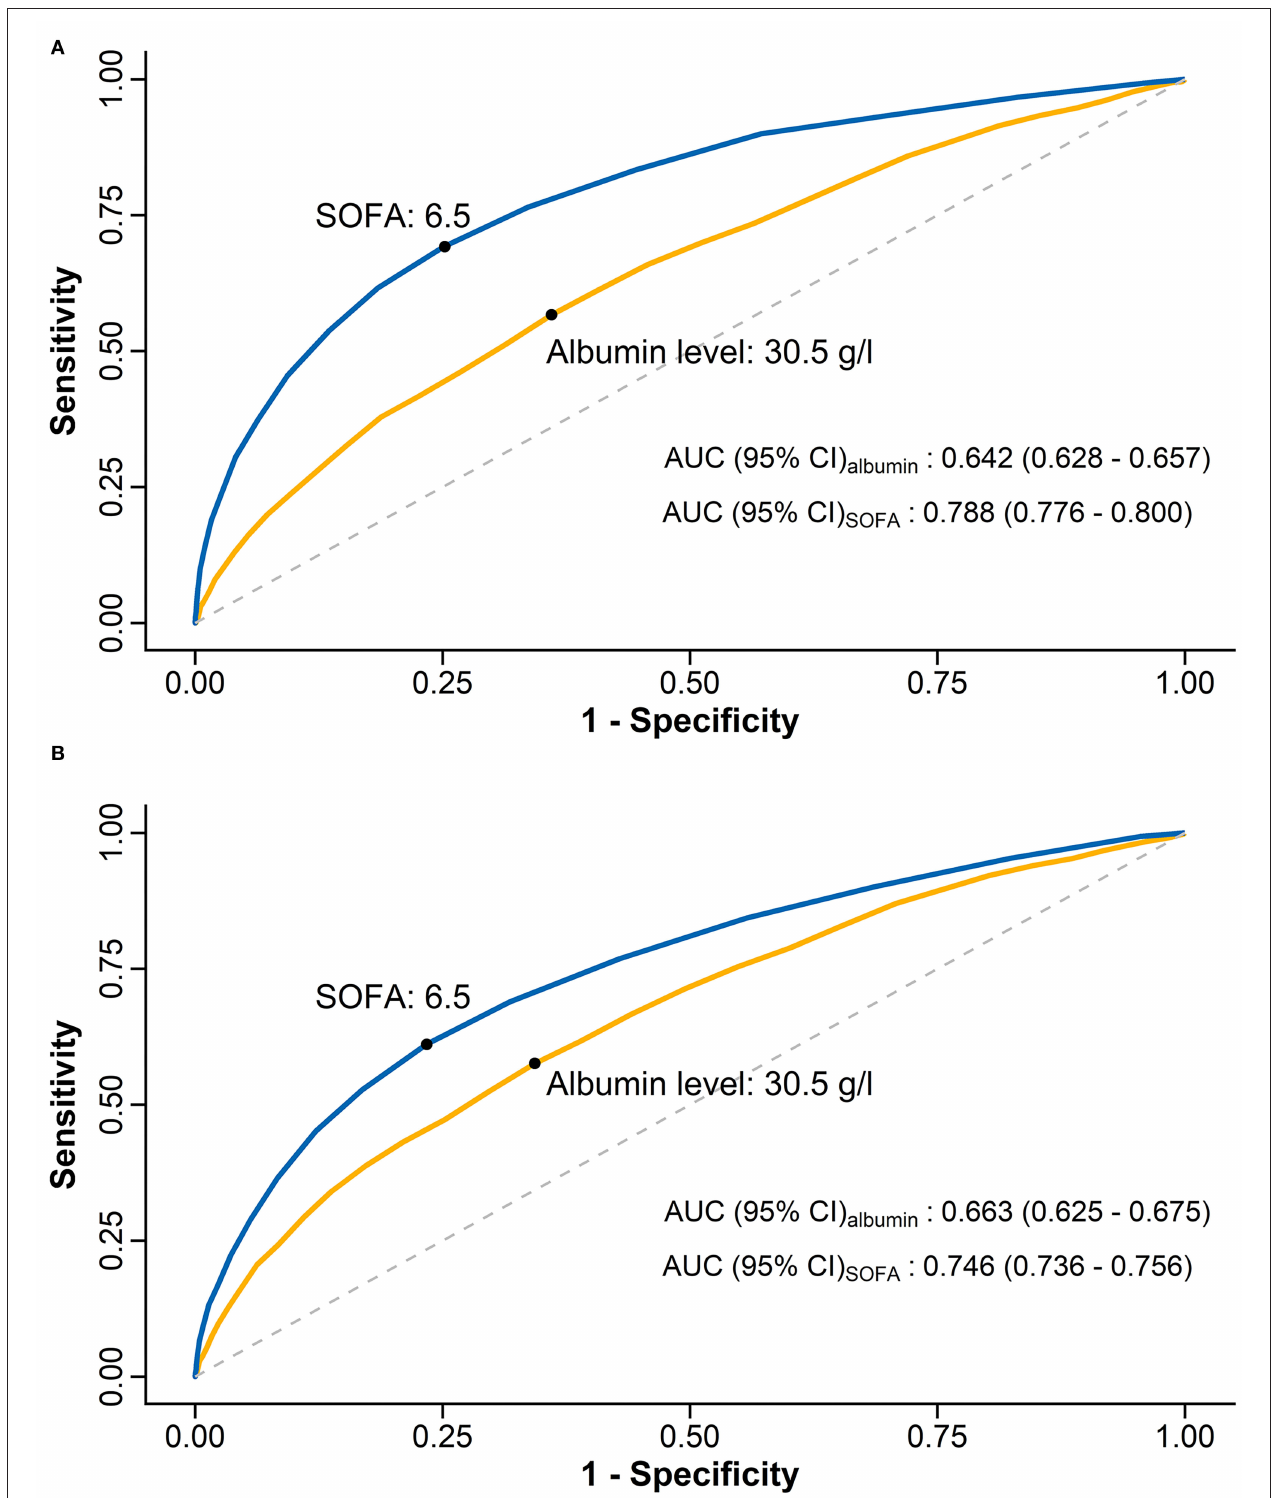
FIGURE 1 | ROC curves and AUC values for admission serum albumin level and SOFA score in predicting ICU (A) and hospital (B) mortalities. ROC, Receiver operating characteristic; AUC, areas under curve; SOFA score, Sequential Organ Failure Assessment score; ICU, intensive care unit.